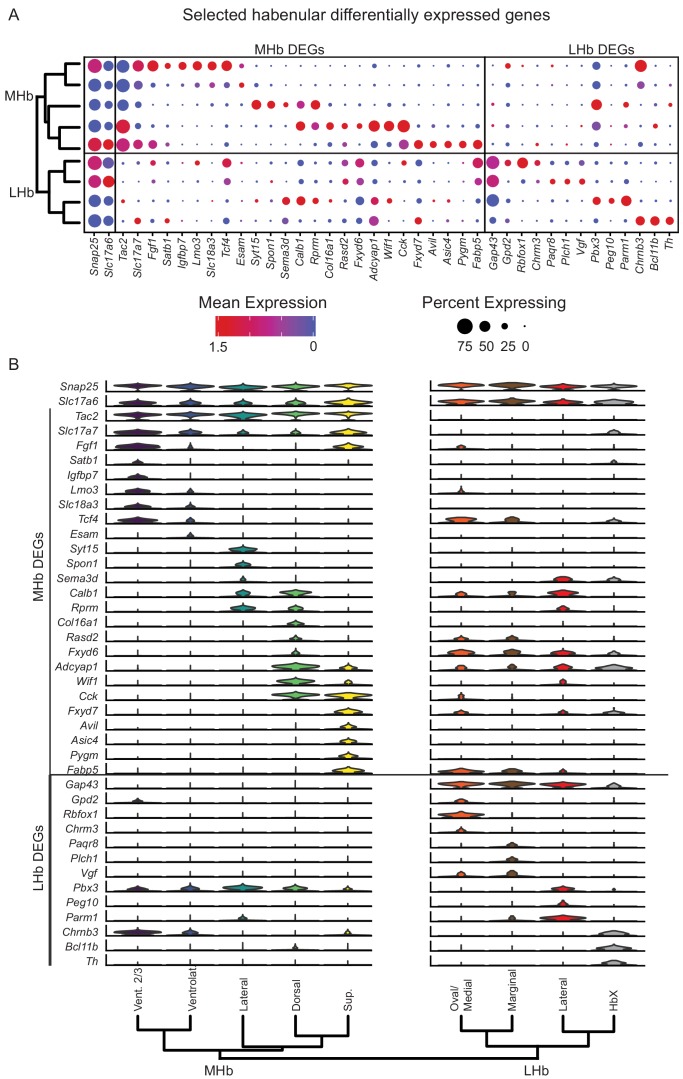
Differentially expressed genes define distinct habenular subtypes.(A) Left: Dendrogram for subclustering of all neurons shown in Figures 2 and 3. Right: Dot plot displaying expression of example differentially expressed genes used to identify each subtype of habenula neuron. The color of each dot (blue to red) indicates the relative expression of each gene, whereas the dot size indicates the fraction of cells expressing the gene. (B) Violin plots of expression level for select MHb and LHb DEGs. The Y-axis maximum for all plots is 5 (log2 transformed and scaled) and minimum is 1. Colored region of the plot shows the probability distribution of all neurons in the labeled cluster. Only representative genes are shown – for entire list of DEGs see Supplementary file 3 and 5.